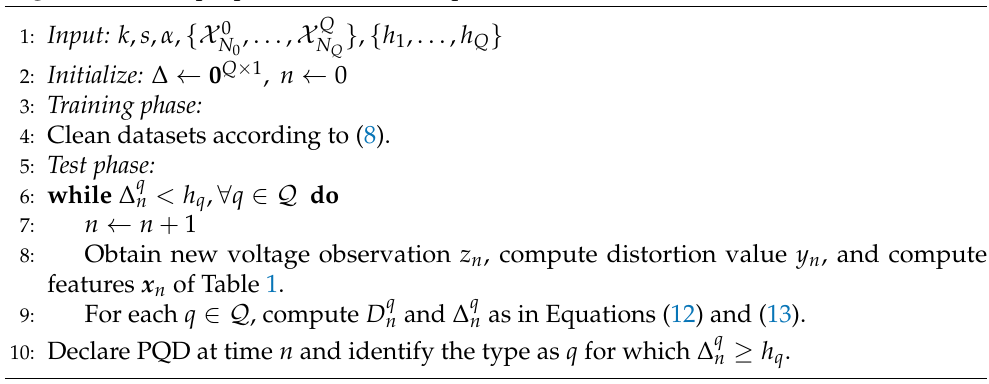
Algorithm 1 The proposed vector-ODIT procedure for PQD